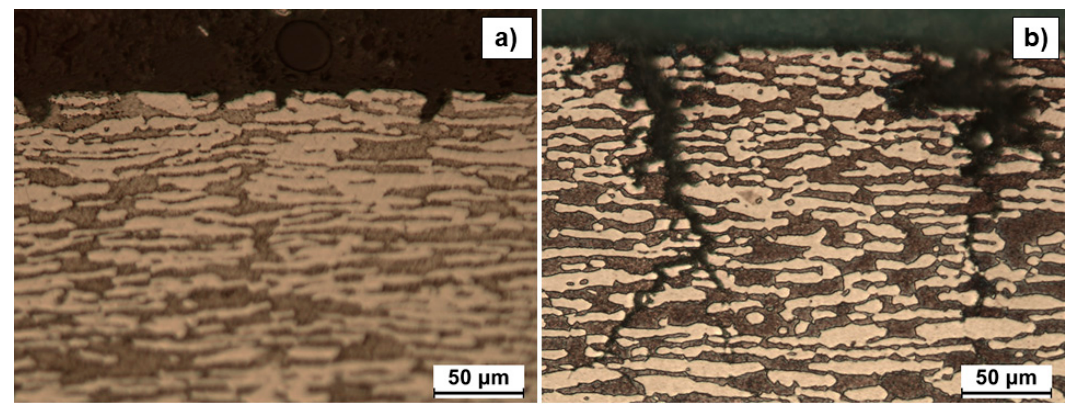
Figure 12. Micrographs of DSS 2304 aged for 5 ( a ) and 10 min ( b ) at 850 °C after SSRT in NACE solution containing 10 − 3 M S 2 O 32 − (long transverse sections, parallel to load direction).